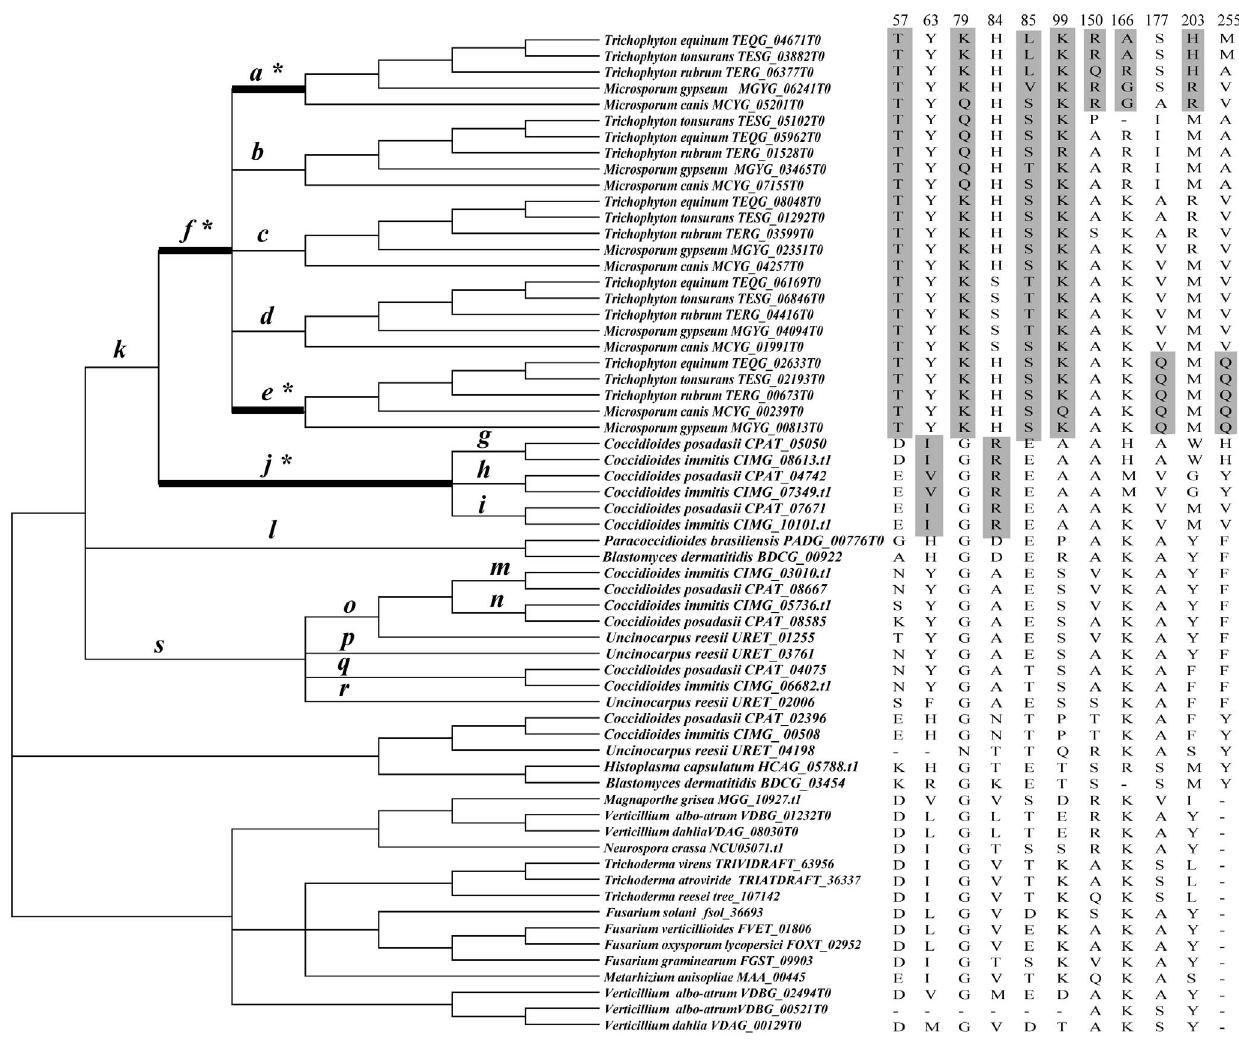
Figure 5. Phylogenetic tree of 62 M35 family genes used for codon-based maximum likelihood analysis in PAML. Phylogenetic trees were collapsed with inconsistent nodes from different tree-building methods and poor statistical supports into polytomy. Branches a-s indicated putative duplication events in Onygenales fungi. The branches with significant evidence of positive selection are indicated as a thick branch. The putative positively selected residues along these branches were shaded in